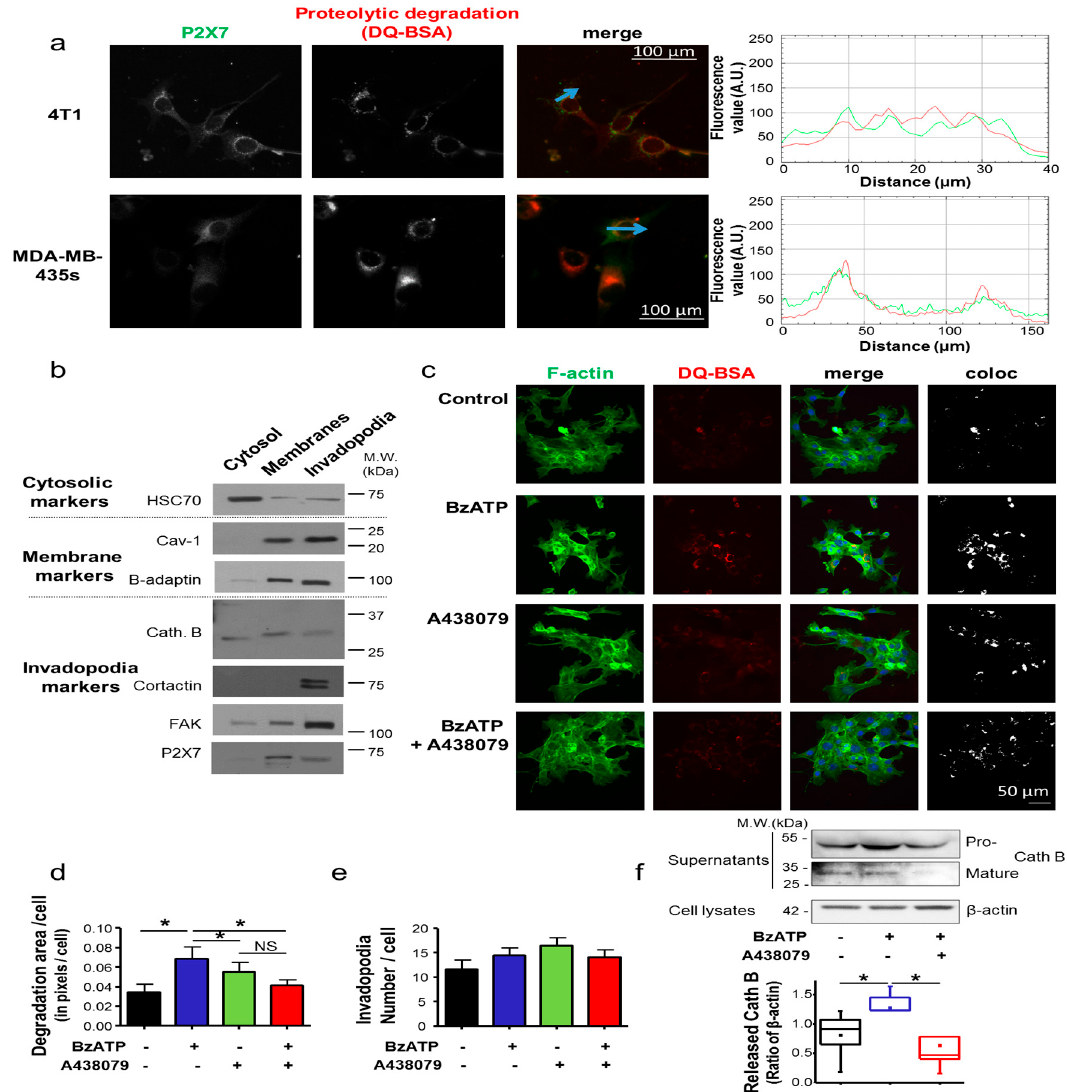
Figure 2. P2X7 receptor promotes invadopodial activity of extracellular matrix degradation. ( a ) 4T1 mouse mammary and MDA-MB-435s human cancer cells were grown on Matrigel ™ containing DQ-BSA as a fluorogenic substrate for proteases, emitting red fluorescence when degraded. P2X7 receptor was immunodetected using a rabbit primary antibody against P2X7 protein and a secondary ant-rabbit IgG antibody conjugated to AF488. The right panel shows the fluorescence values for the two channels at the locations indicated by a blue arrow. Scale bar, 100 µ M. ( b ) Invadopodia entrapped into a 2%-gelatin matrix were fractionated and separated from cytosol and membranes-enriched fractions.